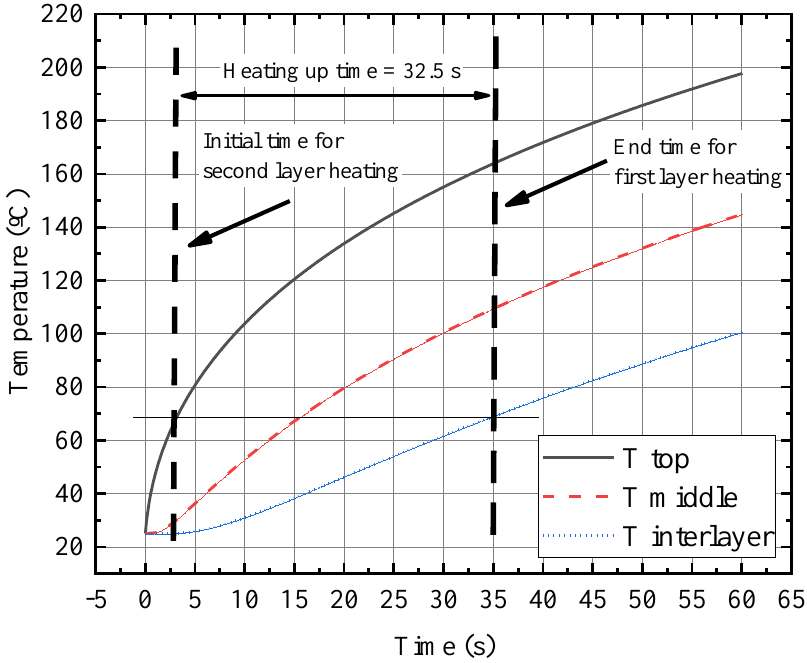
Figure 7. Temperature versus time for three points on the same layer: top surface, middle section, and interlayer point.